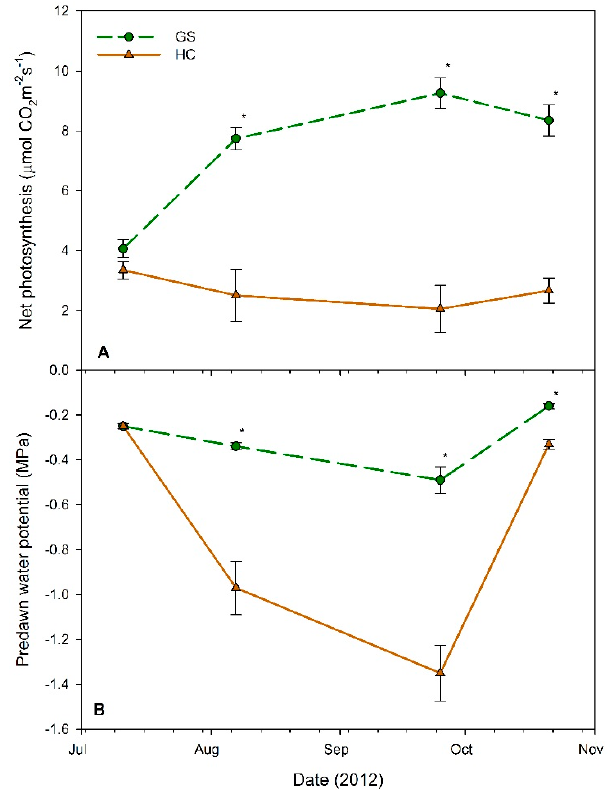
Figure 3. ( A ) Net photosynthesis and ( B ) predawn water potential of Douglas fir seedlings at four measurement dates in 2012. Each point represents the mean ( n = 19–20) across all container sizes, within each vegetative treatment, high competition (HC: solid brown lines, triangles), and glyphosate sprayed (GS: dashed green lines, circles). Error bars represent the standard error of the mean. Points with asterisks (*) indicate a significant difference between HC and GS treatments for that date ( α = 0.05).